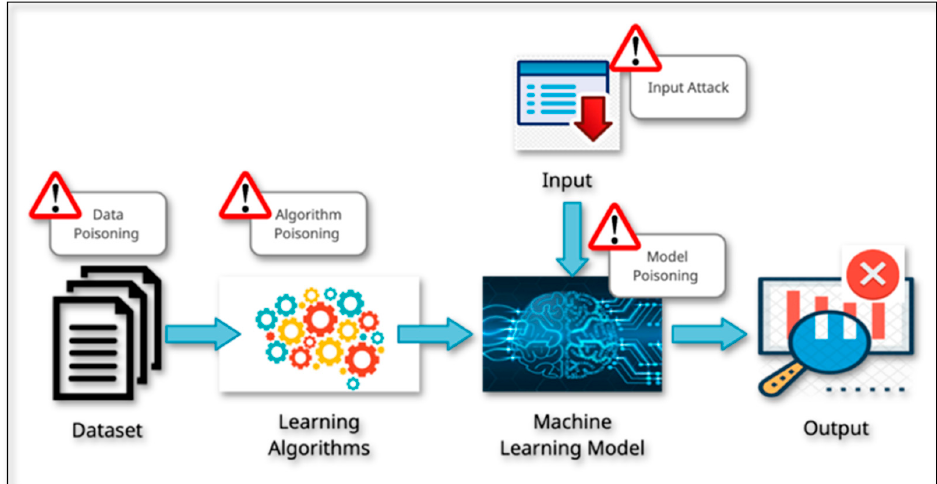
Figure 2. Target areas for attack in AI implementation.